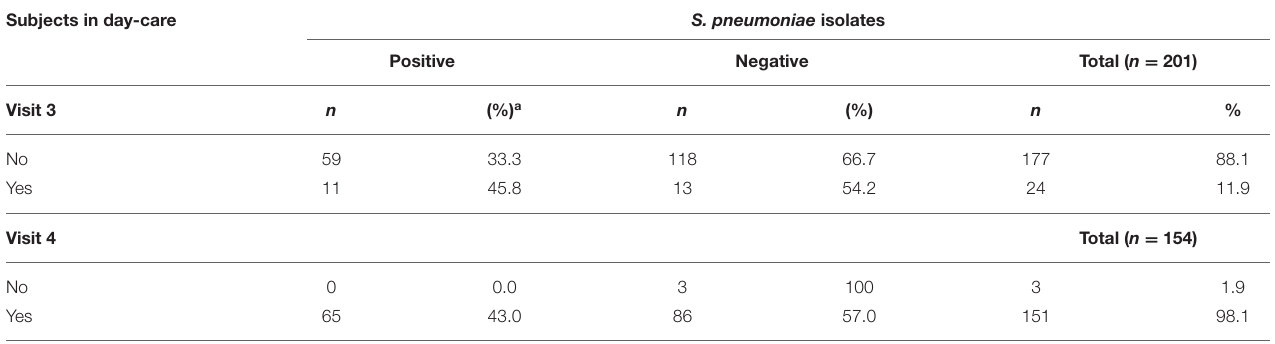
TABLE 5 | Day-care and S. pneumoniae colonization. Subjects in day-care